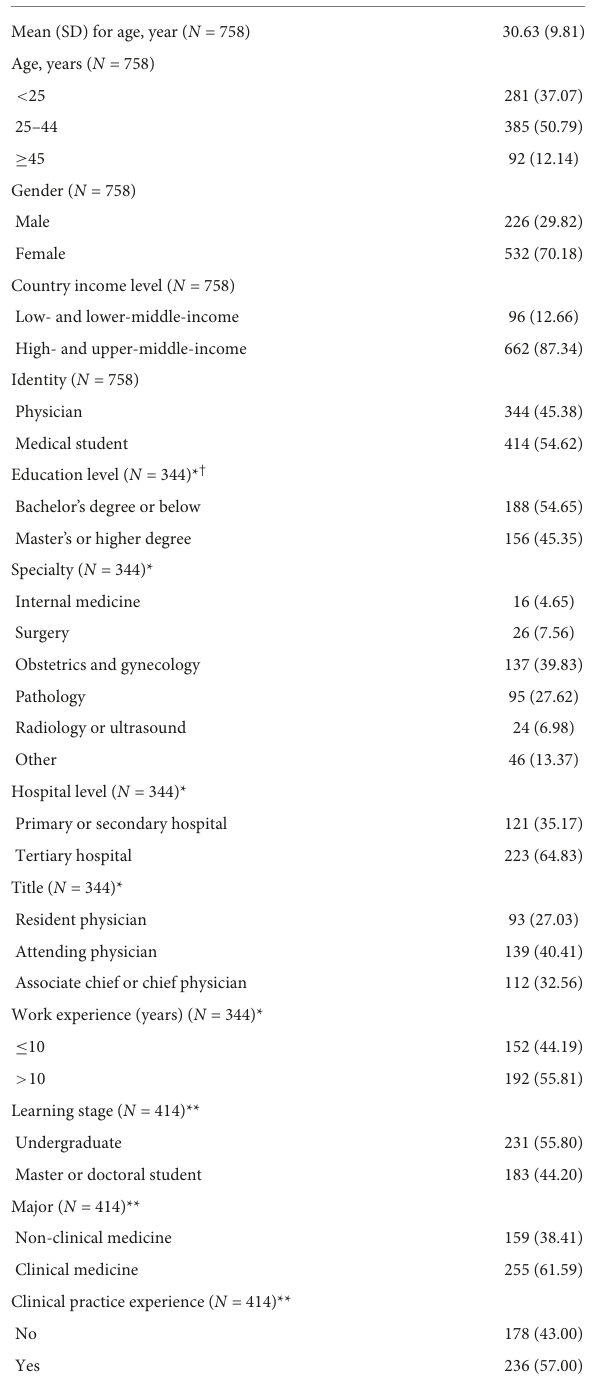
TABLE 2 Respondent characteristics of the questionnaire